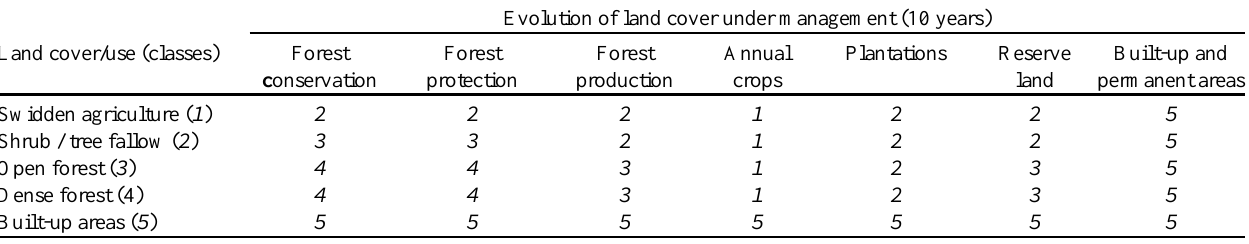
Table 2. Transition matrix for the land-cover/use change model (the numbers correspond to land-cover/use classes displayed in the first column)